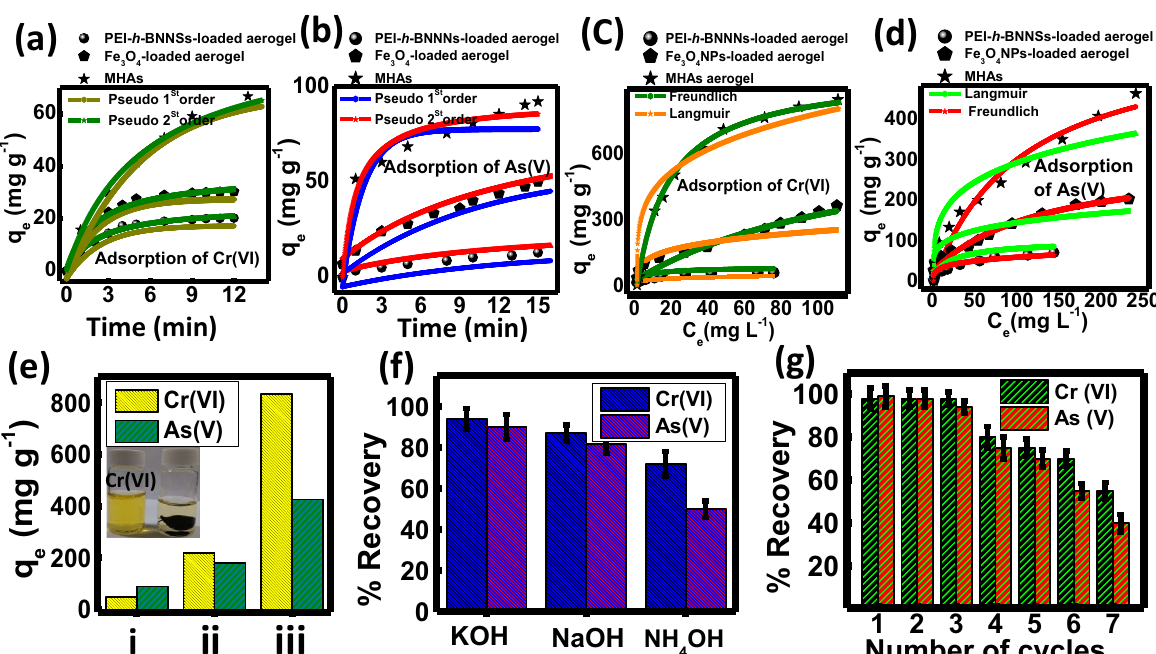
Fig. 6 Modeling studies on heavy metals sorption of isotherm, kinetics and regeneration of adsorbent. Aerogel-mediated removal of Cr(VI) and As(V). Kinetic adsorption curves of the PEI- h -BNNSs-loaded PVA aerogels, Fe 3 O 4 NPs-loaded PVA aerogels, and MHAs for ( a ) Cr(VI) and ( b ) As(V). Modeling of adsorption curves with the pseudo- fi rst-order kinetics ( a : dark yellow curve; b : dark blue curve) and pseudo- second-order kinetic ( a : dark green curve; b : red curve). Adsorption isotherms of the PEI- h -BNNSs-loaded PVA aerogels, Fe 3 O 4 NPs-loaded PVA aerogels, and MHAs for ( c ) Cr(VI) and ( d ) As(V). Adsorption isotherms modeling Fitting with the Freundlich model ( c : dark green curve; d : red curve) and Langmuir model ( c : dark orange curve; d : fl uorescent green curve). e The q max values of Cr(VI) and As(V) on the surface of adsorbents are (i) PEI- h -BNNSs-loaded PVA aerogels, (ii) Fe 3 O 4 NPs-loaded PVA aerogels and (iii) MHAs. f The recovery of Cr(VI) and As(V) obtained from the elution of Cr(V) and As(V)-desorbed from MHAs with 0.1 M of KOH, NaOH, and NH 4 OH. g The reusability of MHAs for capturing and liberating of Cr(VI) or As(V). a – g The aerogels (2.0 g) were incubated with 10 − 600 mg mL − 1 of Cr(VI) or As(V) at pH 7.0 and 298 K for ( a , b , c – g ) 0 − 15